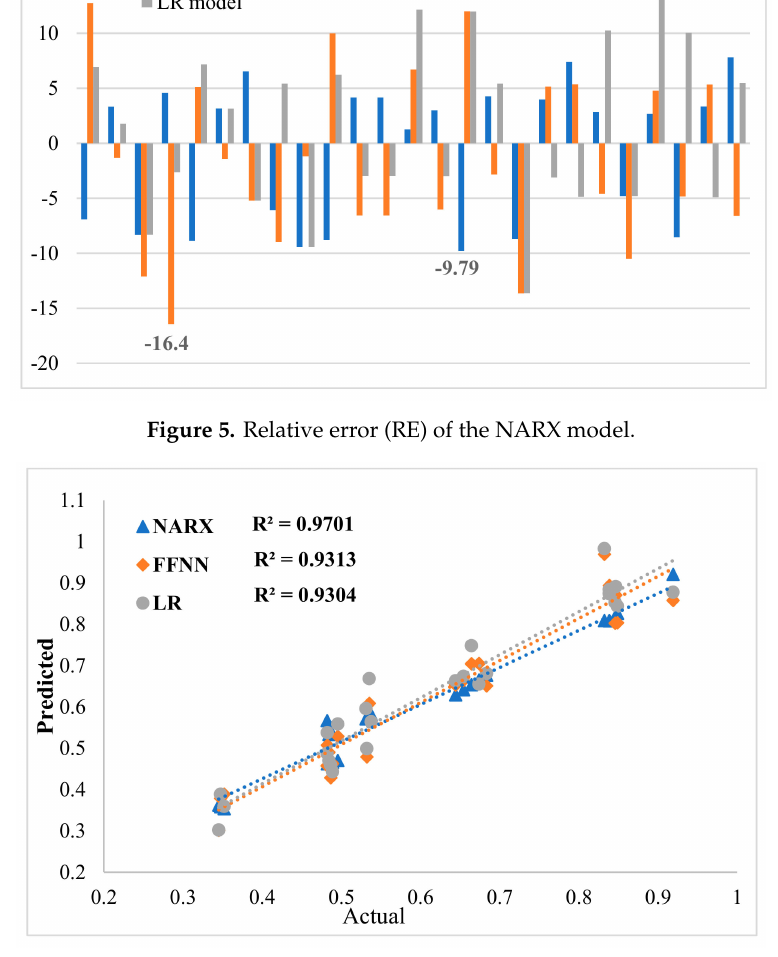
Figure 6. Coe ffi cients of correlation ( R 2 ) of the neural network